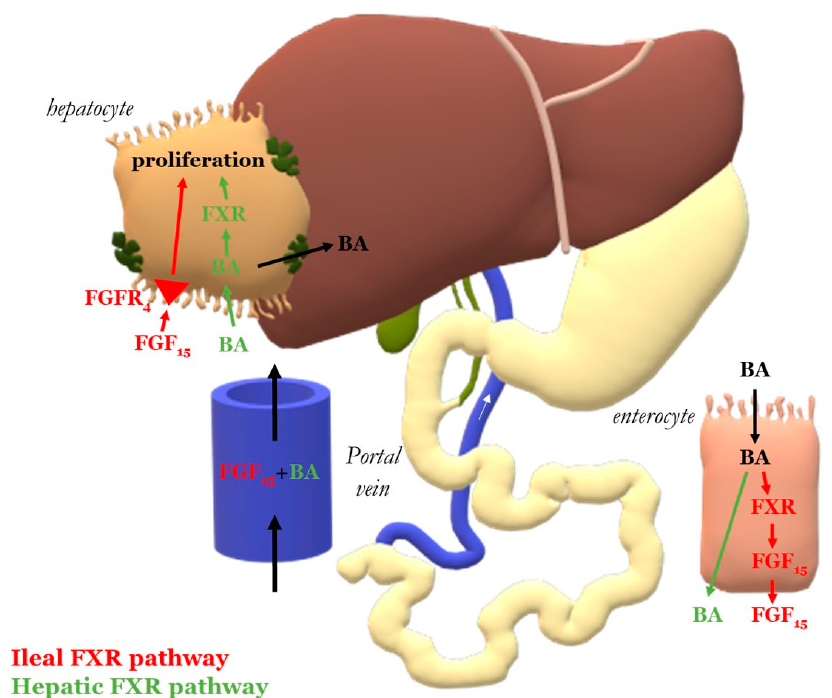
Figure 1. Bile acid (BA) and farnesoid X receptor (Fxr) signaling. Ileal Fxr pathway (red marking): The absorbed BAs activate Fxr signaling in the ileal enterocytes, inducing the production of mitogenic fibroblast growth factor (Fgf)15. After entering the portal circulation, Fgf15 binds to hepatocytes and activates the regeneration pathway via the Fgfr4 receptor. Hepatic Fxr pathway (green marking): absorbed BAs enter the portal circulation and reach the hepatocytes, where they activate hepatocyte Fxr signaling and initiate